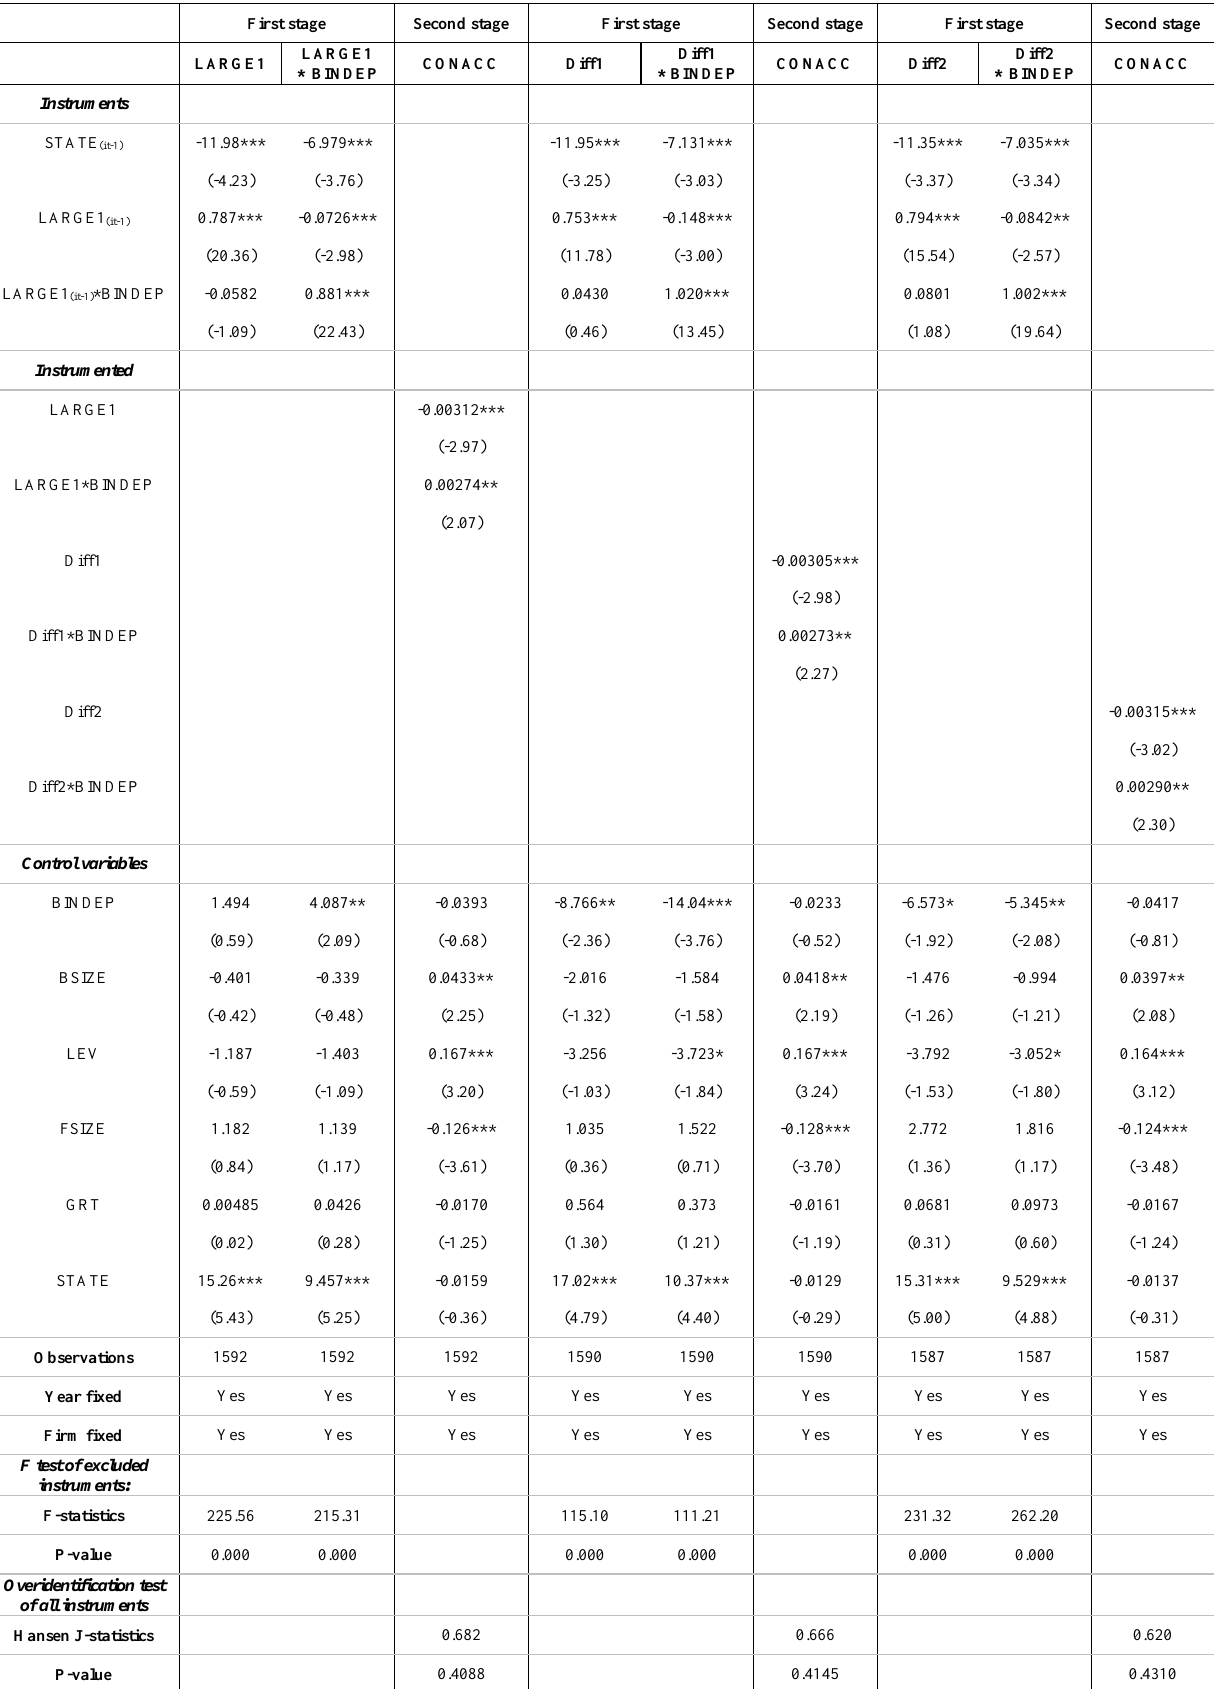
Table 7. Fixed effects instrumental variables estimation for the model including an interaction